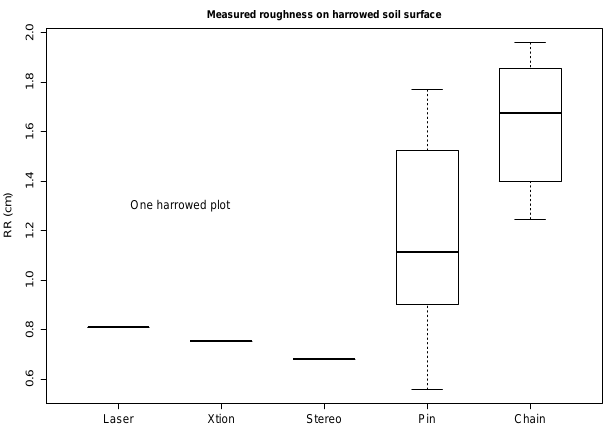
Xtion Pro manages to capture more height differences than